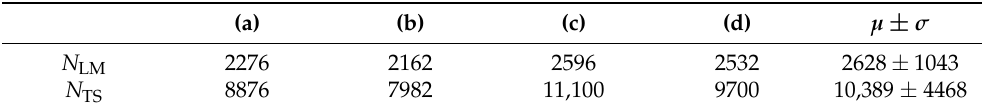
Table 3. Total number of local minima N LM and of transition states N TS of the strongly-disordered NP ensembles illustrated in Figure 5. The corresponding averages µ and standard deviations σ are obtained for 100 different realizations of